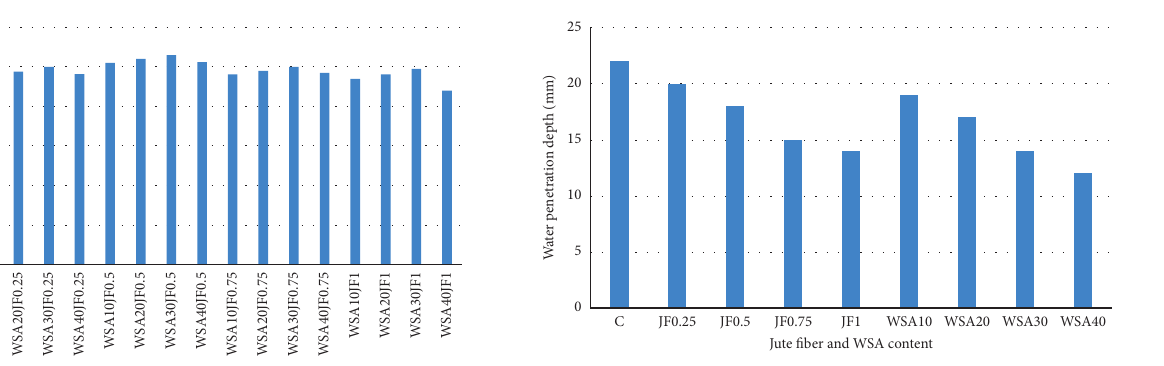
Figure 12: Permeability of mixture containing jute fiber and WSA.